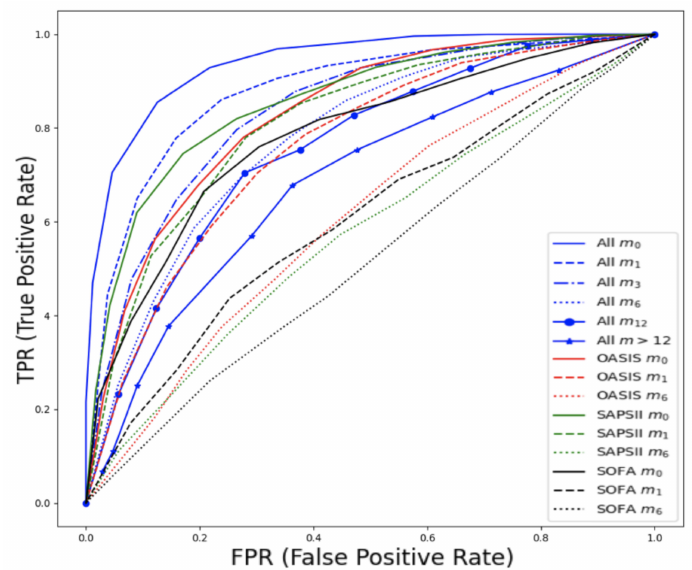
Figure 7. ROC curves for late mortality in ICU patients with cancer from MIMIC-III database, stratified based on the time of death after admission expressed in months ( m 0 , m 1 , m 3 , m 6 , m 12 , > m 12 ). Comparison with traditional clinical scores.